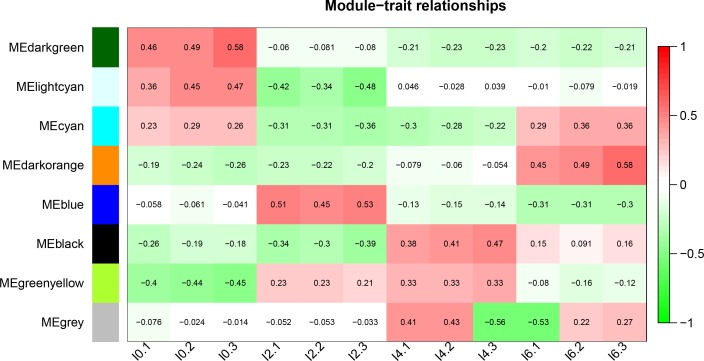
Correlation between modules and differentiation stage.The color, ranging from green through white to red, indicates negative to positive correlation.